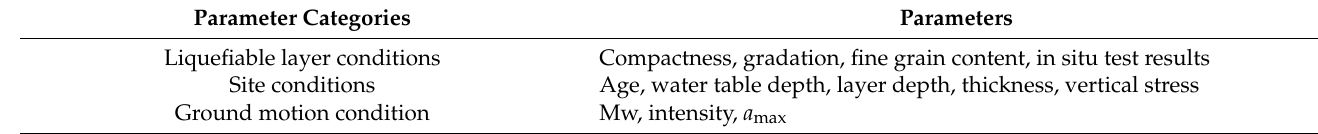
Table 1. Site characteristic parameters.